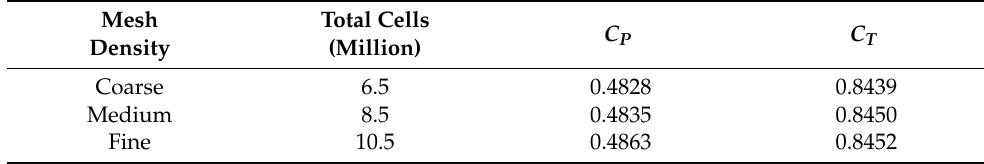
Figure 7. Mesh distribution near the central x - y plane of the two turbines. Table 1. Mesh independence assessment.